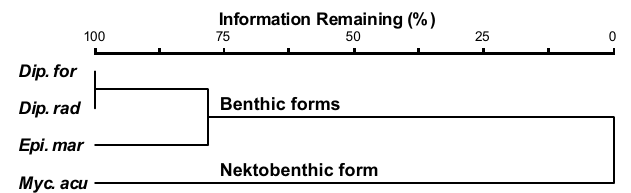
Fig. 4. Dendrogram of ecomorphological relationships (simi- larity) for Diplectrum formosum ( Dip. for. ), Diplectrum radi- ale ( Dip. rad. ), Epinephelus marginatus ( Epi. mar. ), and Mycteroperca acutirostris ( Myc. acu. ). Cluster analysis is by the Euclidean distance measure and Group Average link- age method. The principal difference between the two groups is the body form related to the vertical occupation of the water